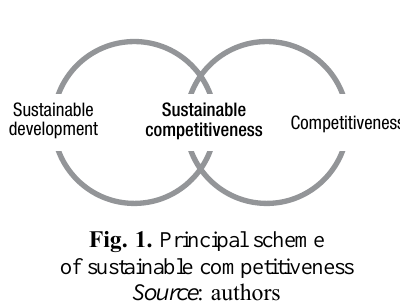
Fig. 1. Principal